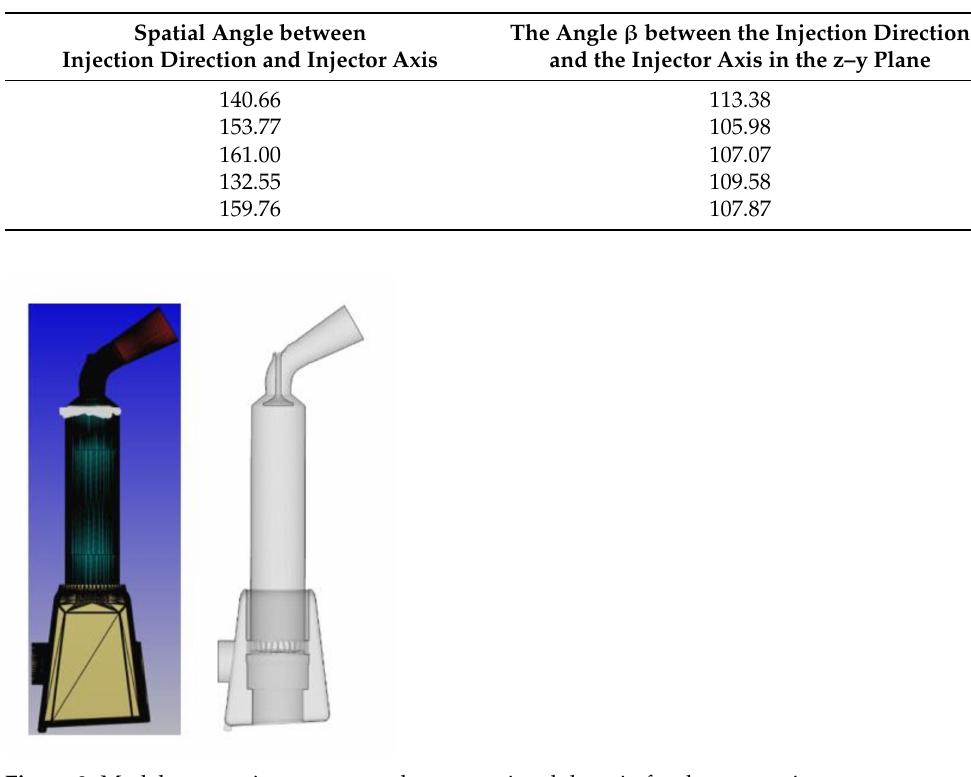
Figure 3. Model geometric structure and computational domain for the test